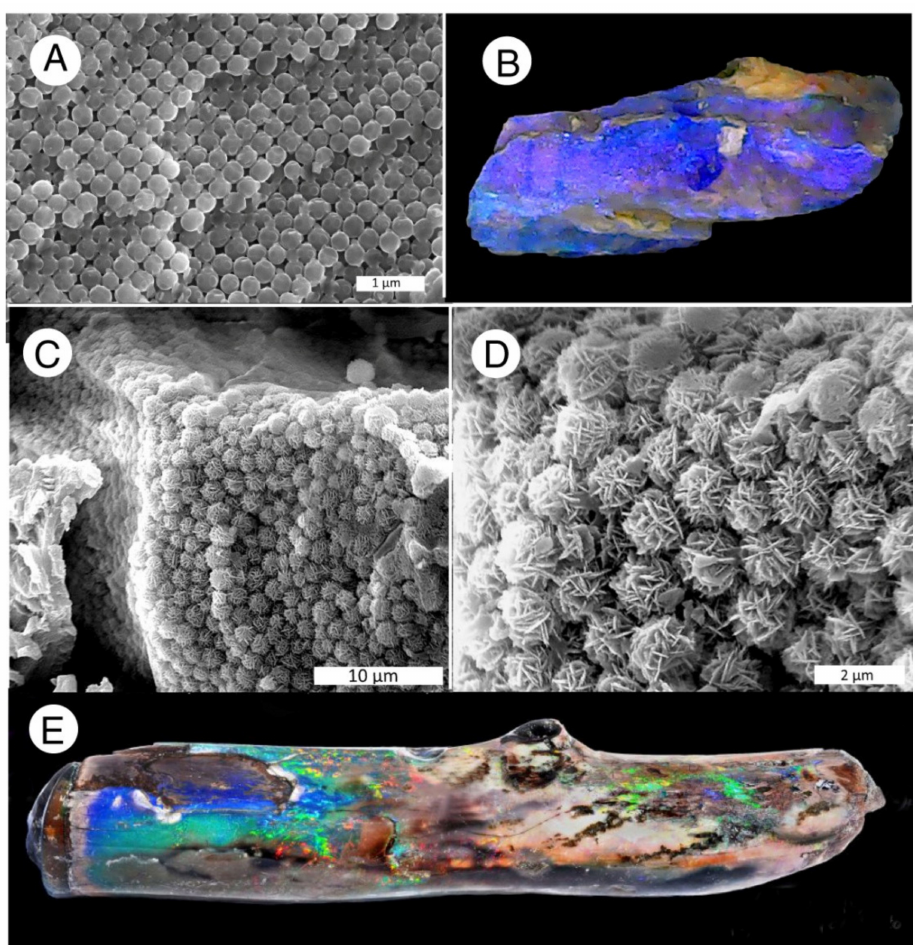
Figure 28. Examples of precious opal. ( A ). SEM image of Australian precious opal. Photo from Mineralogy Division, Geology and Planetary Science, Caltech University, Pasadena, California, USA, Creative Commons license. ( B ) Precious “black opal” replacing wood, Lightning Ridge. New South Wales, Australia. Specimen courtesy of Elisabeth Smith. ( C , D ) Miocene precious opal at Virgin Valley, Nevada, USA owes its play of color to the orderly arrangement of opal-CT lepispheres.